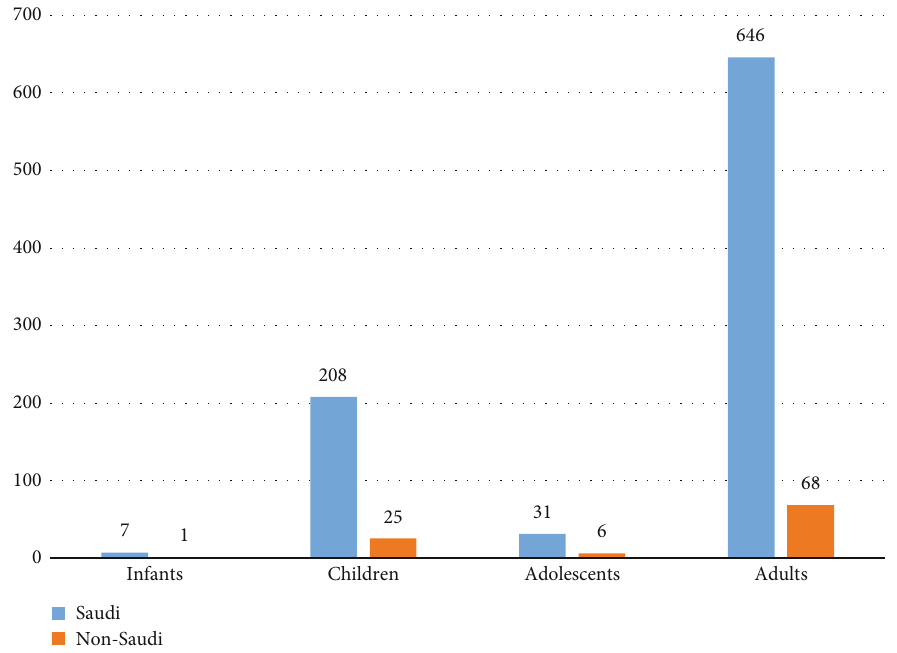
Figure 2: Distribution and proportions of Saudi citizens and non-Saudi residents with primary CNS tumors in di ff erent age